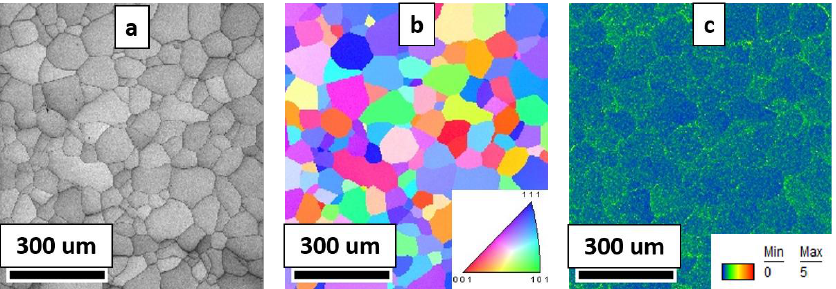
Figure 14. Measured EBSD outputs map of the polished face: ( a ) image quality, ( b ) inverse pole figure, ( c ) kernel average misorientation.